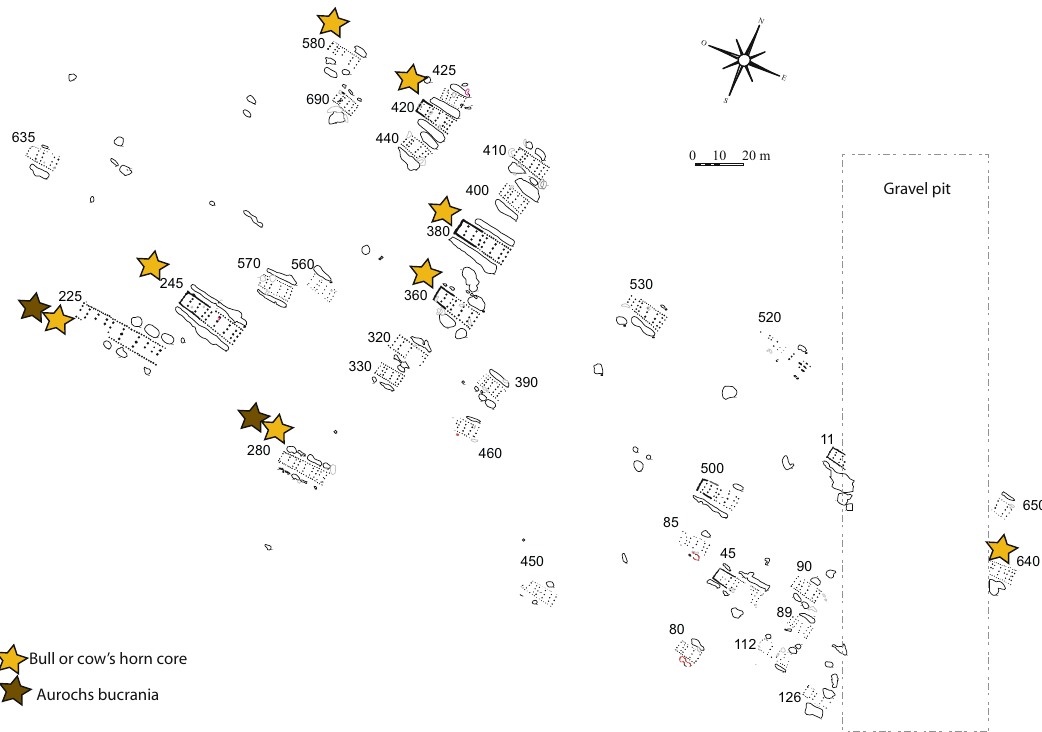
Figure 9: Cuiry - lès - Chaudardes. Distribution of cattle horn cores or bucrania per